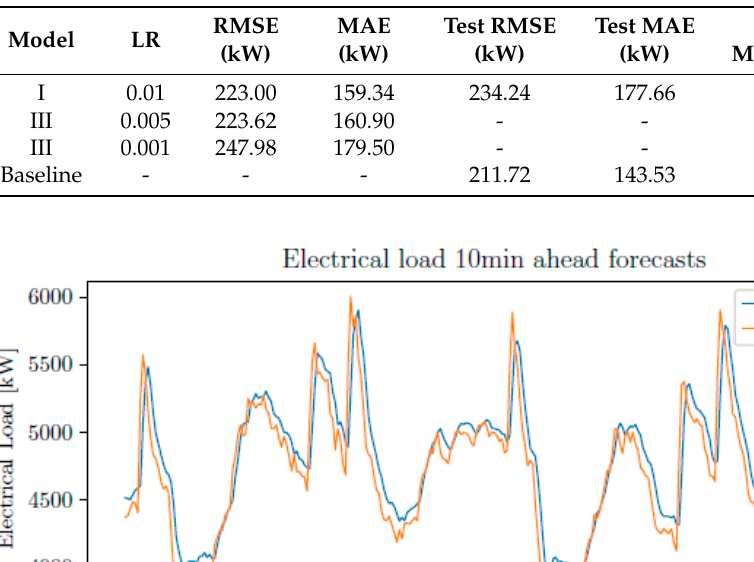
Table 3. Results of the 10-min-ahead initial and baseline models.